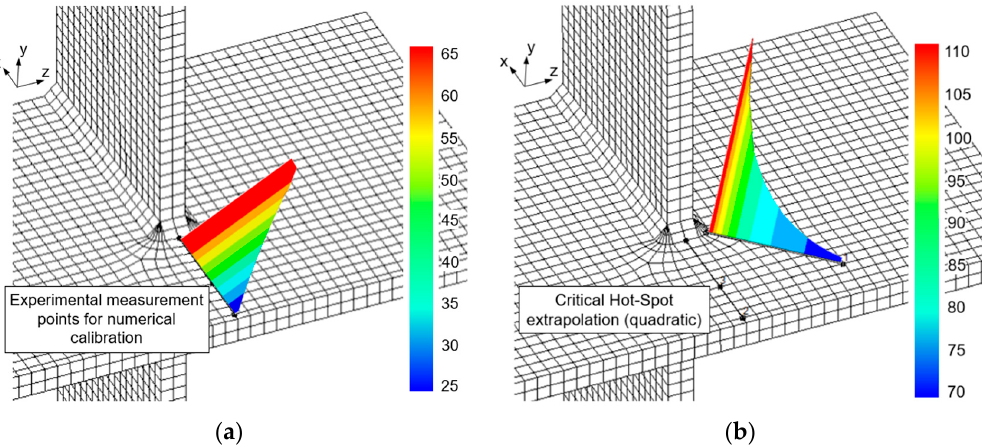
Figure 13. Surface extrapolated structural stresses computation with reference points: ( a ) linear extrapolation compatible with experimental measurements; ( b ) quadratic extrapolation at weld corner looking for critical hot-spot stresses.